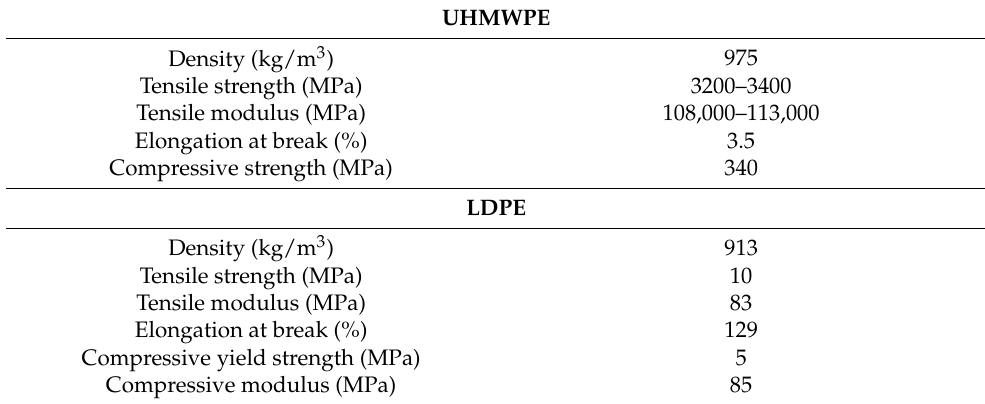
Table 1. Properties of fiber (UHMWPE) and matrix (LDPE) obtained from